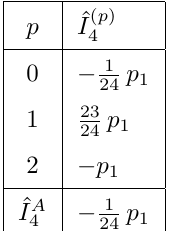
Table 5 . The four-form anomaly polynomials for chiral fermionic p -forms in D = 2 .